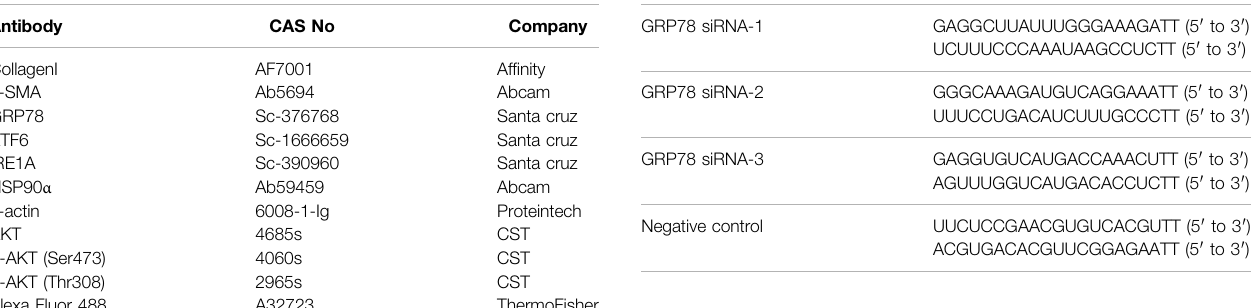
TABLE 2 | The sequences of